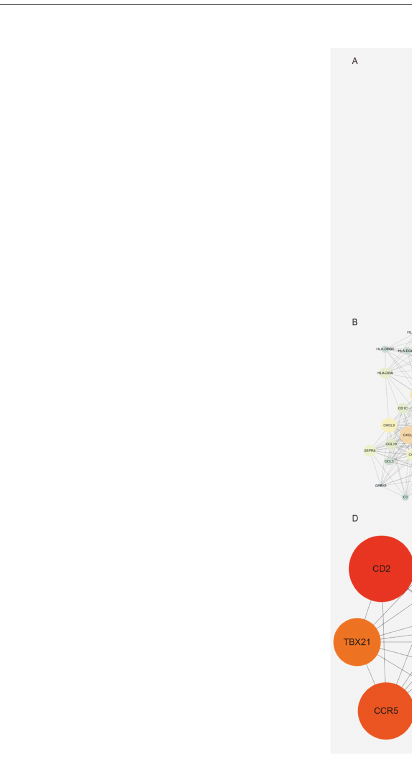
FIGURE 5 | Gene module analysis and characteristic molecular screening. (A) PPI network diagram, 219 difference interaction diagrams were obtained by using the String website. (B, C) Characteristic module analysis. (D) The top 10 characteristic molecules were obtained by the screening of characteristic molecules. (E) CMAP mode of action analysis (MoA) was used analyze the molecular pharmacological mechanism enrichment of related